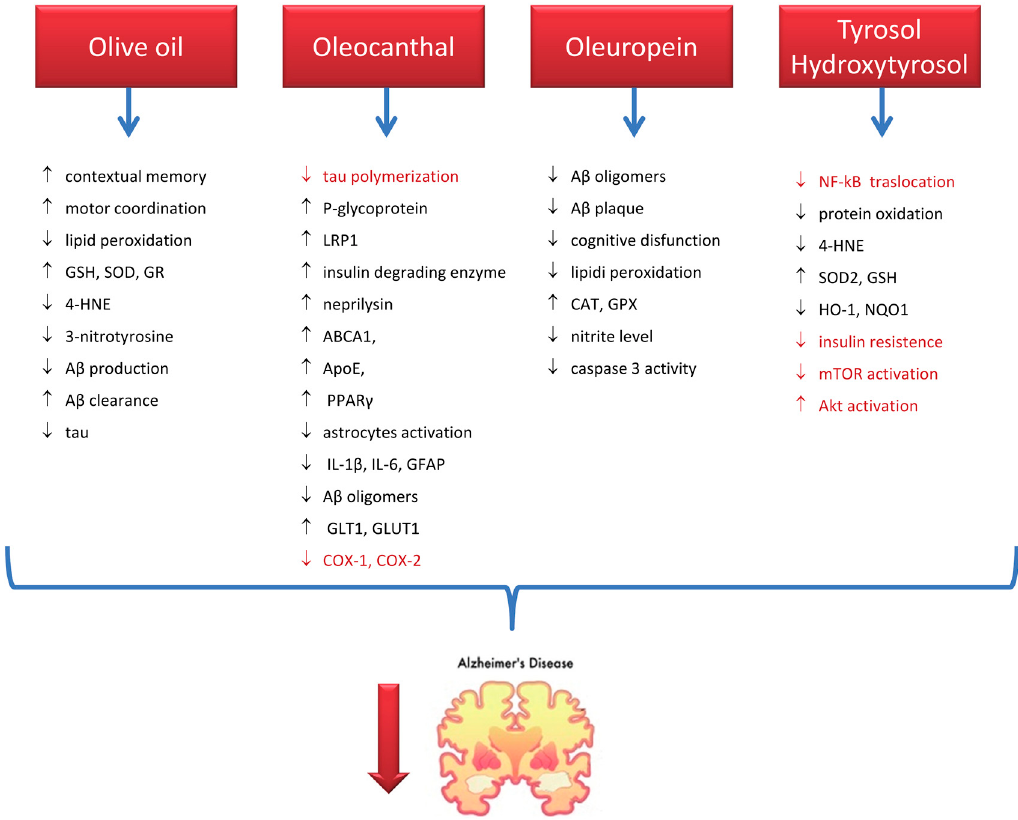
Figure 2. Mechanisms of action of olive oil and its phenols in preventing/counteracting AD. Black indicates results from animal studies, red from in vitro studies. ↓ stands for inhibition, ↑ stands for activation. GSH: reduced glutathione, SOD: superoxide dismutase, GR: glutathione reductase;